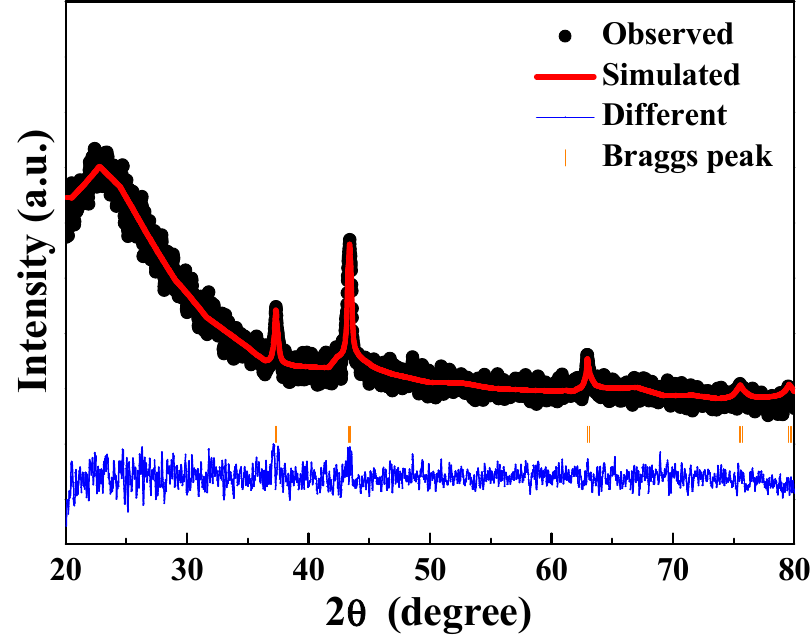
Figure 4. Rietveld refinement of the L2NiO thin films produced with an annealing temperature of 600 ° C for 3h.